Question: In a single sentence, describe what this figure presents.
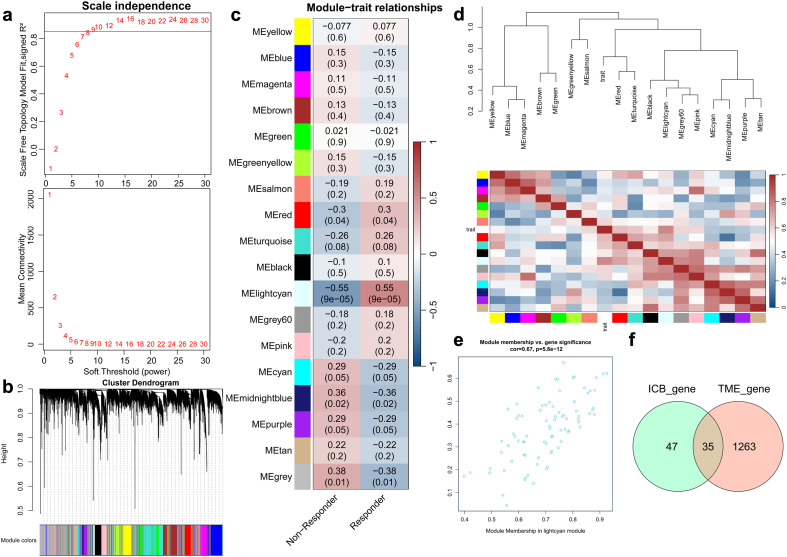
Answer: Identification of immunotherapy-related hub genes via WGCNA. This study examines (A) the analysis of network topology for various soft-thresholding powers, (B) the cluster dendrogram of genes grouped into distinct modules, (C, D) the correlation between modules and clinical traits (Responder vs. Non-Responder) and the module eigengene adjacency, (E) the correlation between module membership and gene significance in the lightcyan module, and (F) the intersection of ICB-related genes and TME-related genes shown in a Venn diagram.